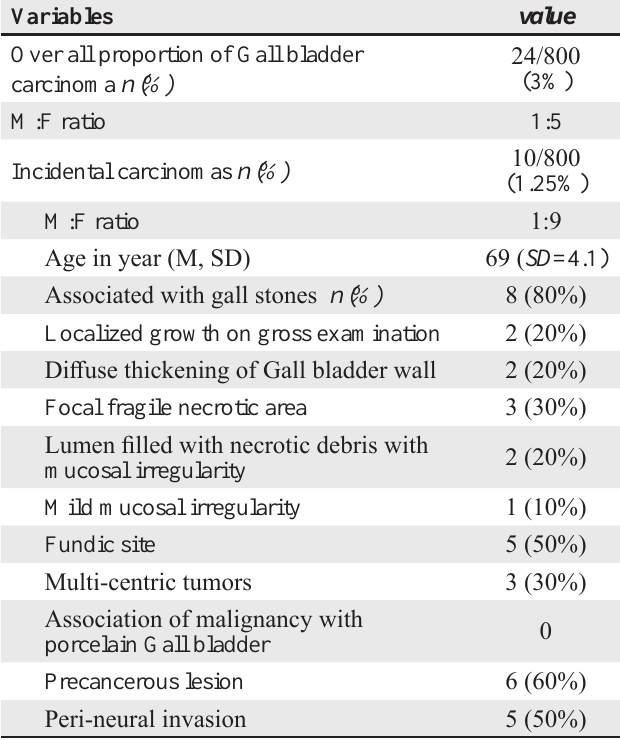
Table 1 : Clinicopathological Features of Incidental gallbladder Carcinoma.